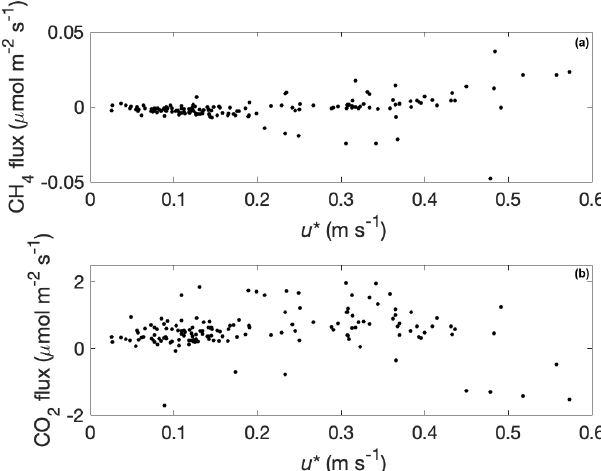
Figure 8. Methane (a) and carbon dioxide (b) fluxes as a function of friction velocity ( u ∗ ) when bison were absent from the study pas-